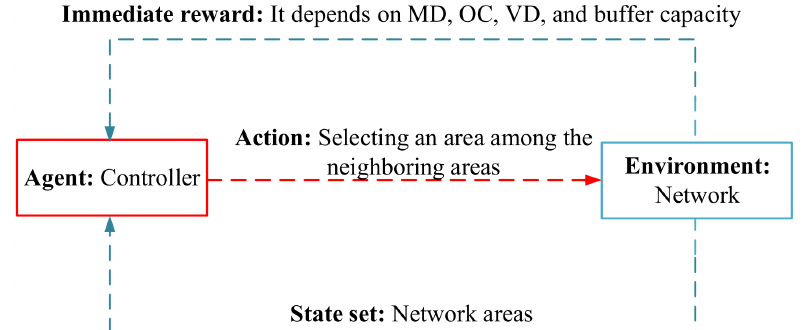
Figure 19. Learning structure in